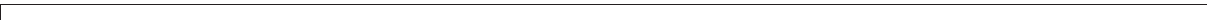
FIGURE 2 | corticotropin-releasing hormone (CRH) as well as adrenocorticotropic hormone (ACTH). Then, it can augment the production of glucocorticoids (GCs) released by adrenal cortical cells and inhibit excessive inflammation, which may alleviate the sepsis-induced CNS inflammation. However, severe sepsis can result in damage to the HPA axis and the abnormal induction of GC, thereby contributing to immunosuppression and intractable inflammation of the CNS. Of note, the constant brain damage aggravates the abnormality of the HPA axis and forms a vicious cycle under septic exposure. In addition, the activated splenic nerve can release norepinephrine (NP), which binds to the adrenaline receptor (ADR) on immune cells such as CD4 + T cells, dendritic cells (DCs), and macrophages to produce ACh. ACh binds to α 7 nAChR on the inflammatory cells and suppresses the inflammatory response in the spleen. Nevertheless, the persistent activation of the vagus nerve may lead to the development of host immune suppression following septic